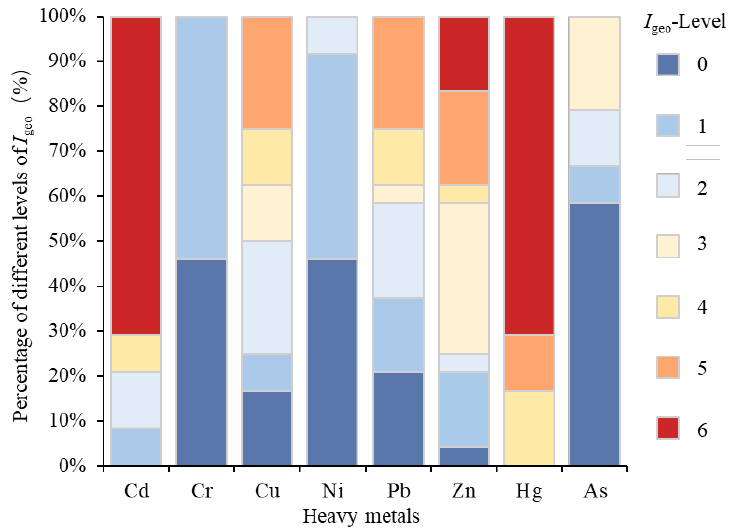
Figure 3. Geo-accumulation indexes level distribution of heavy metals in sediments from the Huafei River. Note: 0: Unpolluted. 1: From unpolluted to moderately polluted. 2: Moderately polluted. 3: From moderately to strongly polluted. 4: Strongly polluted. 5: From strongly to extremely polluted. 6: Extremely polluted.